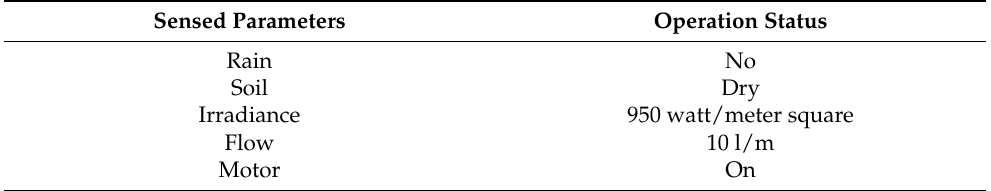
Table 4. Physical parameters of smart-sensor-based solar-powered system under no rain and motor on